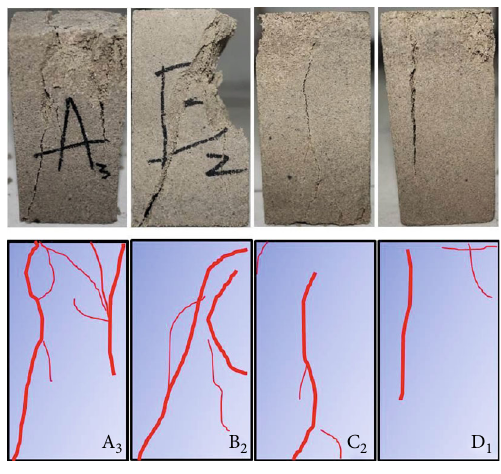
Figure 8: Failure pattern and sketch of mudstone under uniaxial loading after acidic solution corrosion.